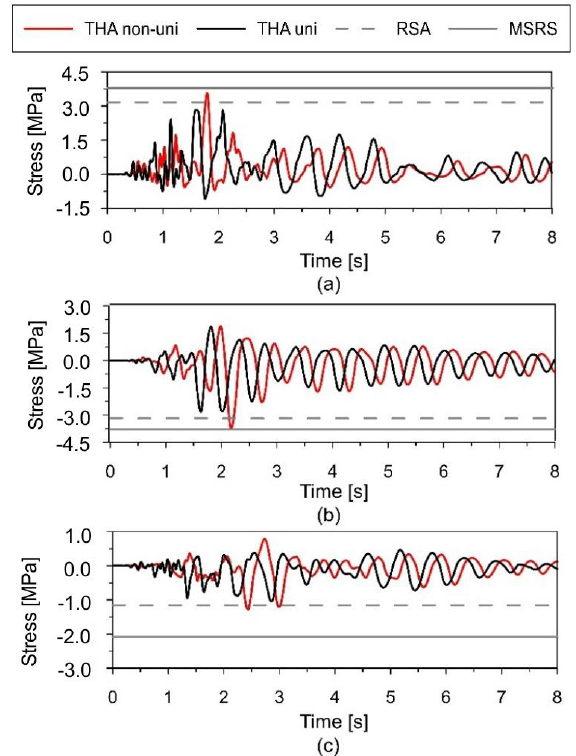
Figure 17. Comparison of extremal principal stresses obtained from di ff erent calculation methods for the mining-induced shock in the USCB region at the support zone elements: ( a ) W4; ( b ) W5; ( c ) W6.